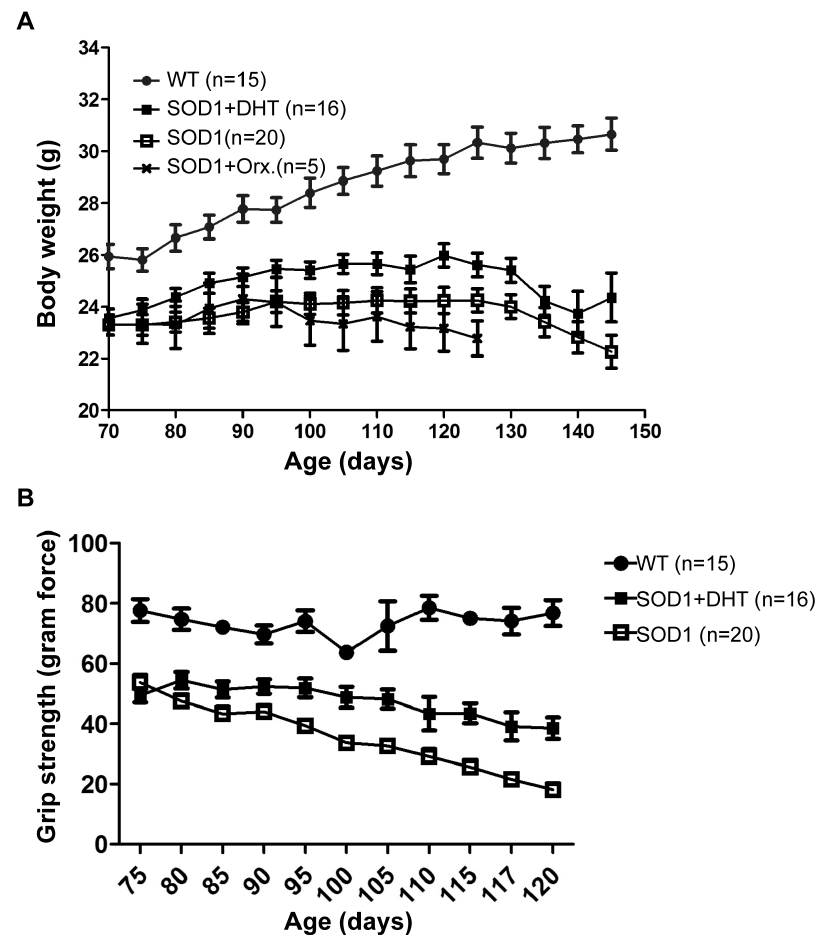
Figure 3. DHT increases body weight and muscle strength in SOD1 mice. A: DHT-treated SOD1 mice showed heavier body weight compared with control SOD1 mice ( p , 0.001), although it was still lower than the weight of WT mice throughout all time points. Orchidectomized SOD1 mice demonstrated reduced body weights compared with control SOD1 mice ( p =0.045). Data are mean 6 SEM. B: The grip-strength meter was used to assess the muscle strength, and the maximum tension generated by the grip of a mouse on the pull bar was recorded. SOD1 mice exhibited diminished grip-strength compared with WT mice throughout all time points examined ( p , 0.0001). DHT-treated SOD1 mice showed stronger grip-strengths compared with control SOD1 mice ( p , 0.001), and the gap between these two groups gradually increased as age advanced. Data are mean 6 SEM. doi:10.1371/journal.pone.0037258.g003 grip-strength meter, which measures the maximum tension generated by the grip of a mouse on the pull bar. As shown in Fig. 3B, SOD1-G93A mice exhibited 40% reduced grip-strength compared with wild-type mice at P90, and the grip-strength gradually weakened to reach only 20% of wild-type grip-strength at P120. DHT treatment increased grip-strength by about 20% stronger at P90 and 200% stronger at P120 in SOD1-G93A mice (Fig. 3B).